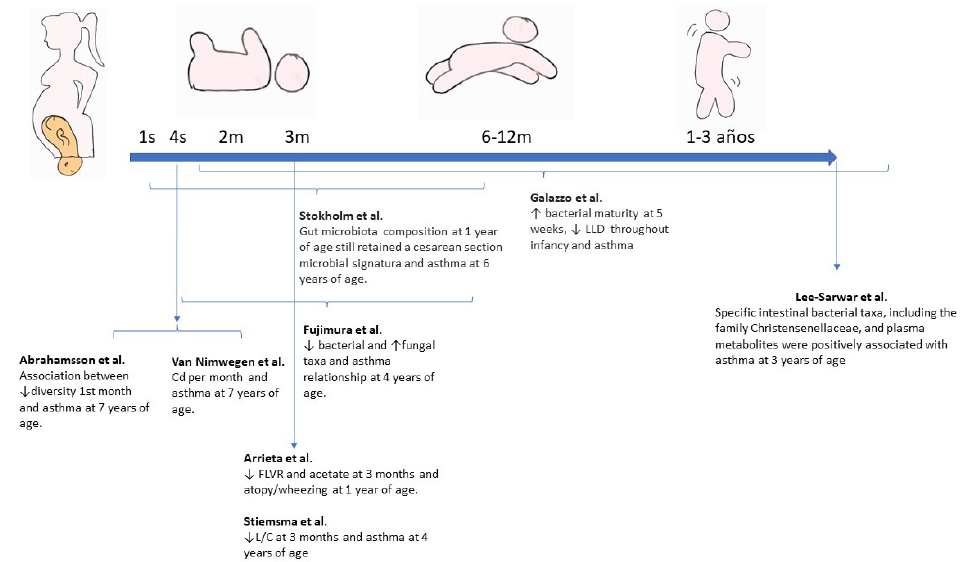
Figure 2. Main studies on intestinal microbiome and its relationship with childhood asthma. Modified and with permission from Valverde-Molina J. [22]. NF: Nasopharyngeal; Sp: Streptococcus